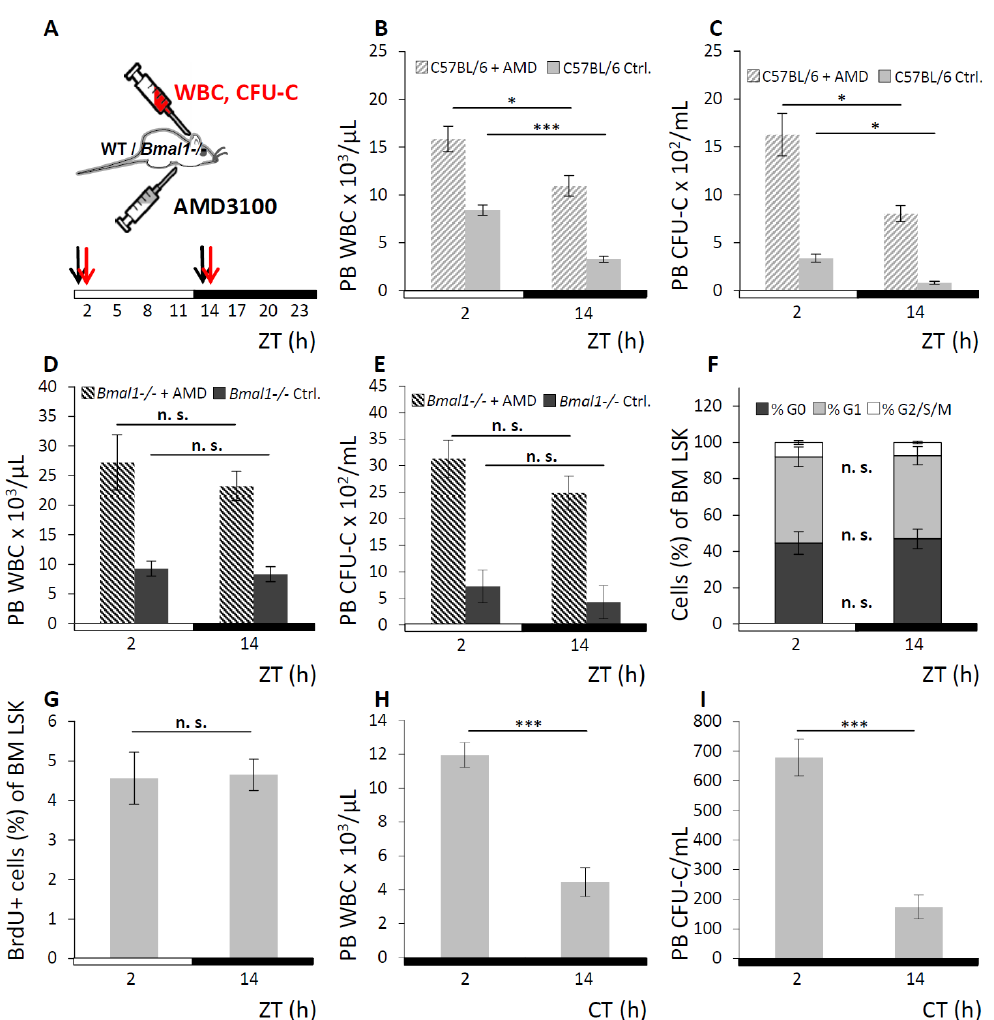
Figure 3. Augmented circadian hematopoietic cell oscillation under AMD3100. A. Scheme of the AMD3100 mobilization experiment: WT and Bmal1 − / − mice were held under LD conditions and received i.p. injections of AMD3100 at ZT1 and ZT13 (black arrows). PB was collected at ZT2 and ZT14 (red arrows) and analyzed for leukocyte content. B, C. WT mice received AMD3100 (hatched bars) or saline injection (solid grey bars) and were analyzed for circulating WBC ( B ) and CFU-C counts ( C ) with n = 9 mice per each group and time point. D, E. Bmal1 −/− mice received injections of AMD3100 (hatched bars) or saline (dark grey bars), followed by WBC ( D ) and CFU-C enumeration ( E ), n = 6 mice per each group and time point. F – I. Circadian oscillation of hematopoietic cells is due to differential cell distribution. F, G. Cell cycle activity of BM LSK cells was assessed by Ki67/7-AAD co-staining ( F , G0 phase depicted in dark grey, G1 phase in light grey and G2/S/M phase in white) or BrdU incorporation ( G ) at ZT2 and ZT14 after 3-h BrdU pulsing ( n = 6 mice per time point). H, I. Splenectomized WT mice were kept under DD conditions and analyzed for PB WBC ( H ) and CFU-C content ( I ) at CT2 or CT14 ( n = 5 mice per time point). Asterisks: * p < 0.05, *** p < 0.001.